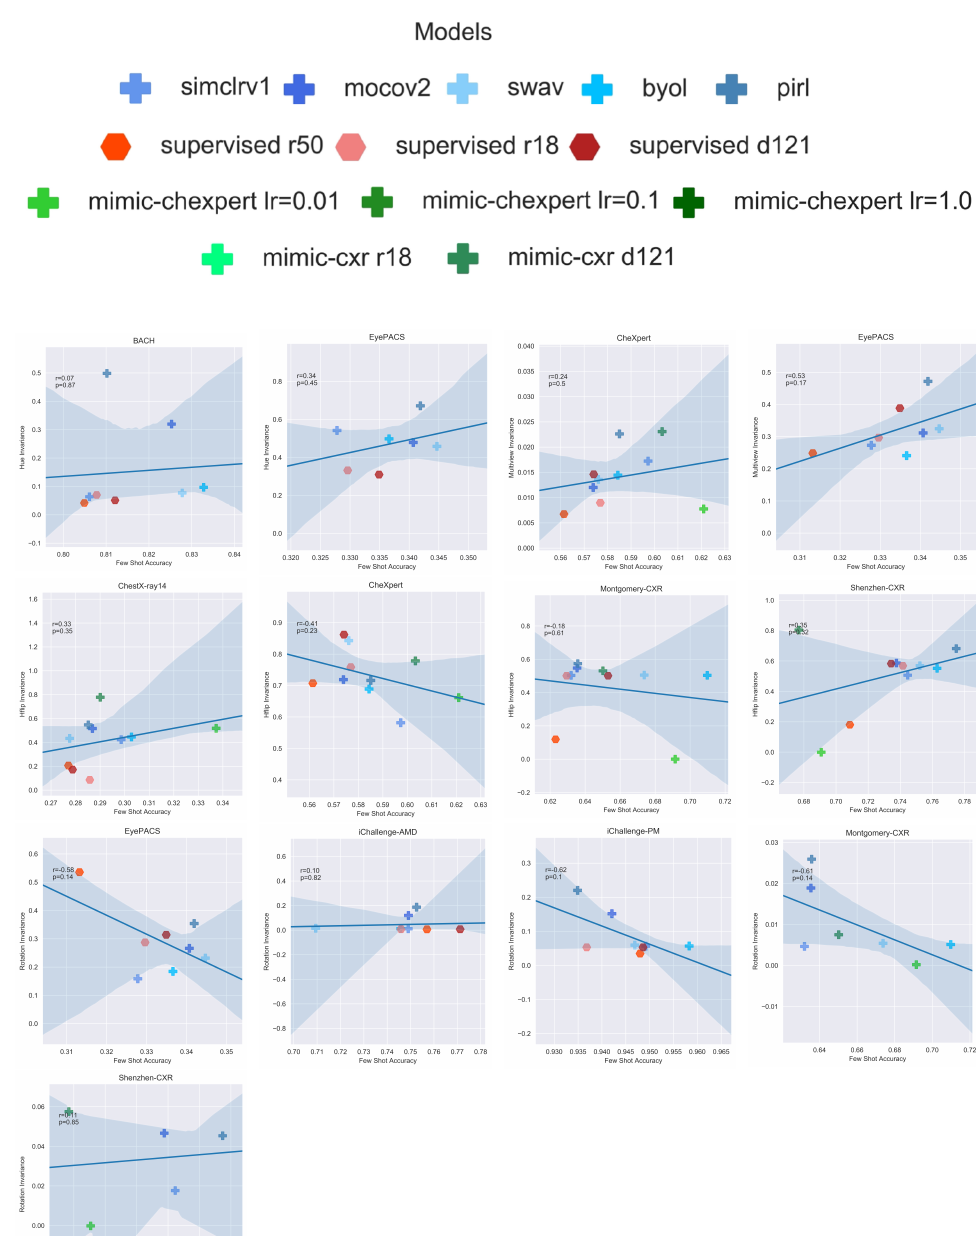
Figure A1. Invariances, as measured by cosine similarity (Equation (3)), plotted against few-shot performance for the different medical datasets. The invariances plotted include rotation, horizontal flip, hue transform and multi-view (the invariance considered in each plot can be found in the y-axis label). Shown overlaid are the Pearson’s r correlation coefficients and associated p values. We find no significant correlations for any of the plots (high p values), except for multi-view invariance on CheXpert, which shows a strong positive correlation.